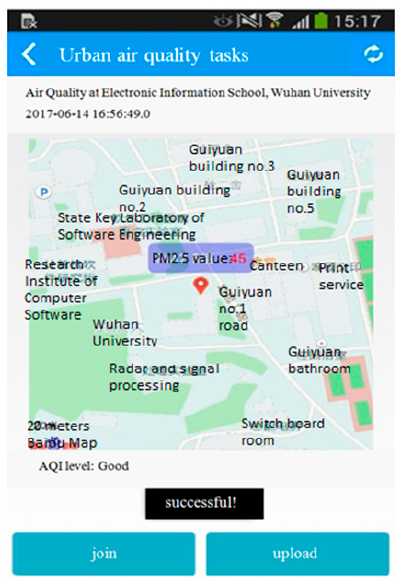
Figure 4. The screenshot of air sensing android-based smartphone client.